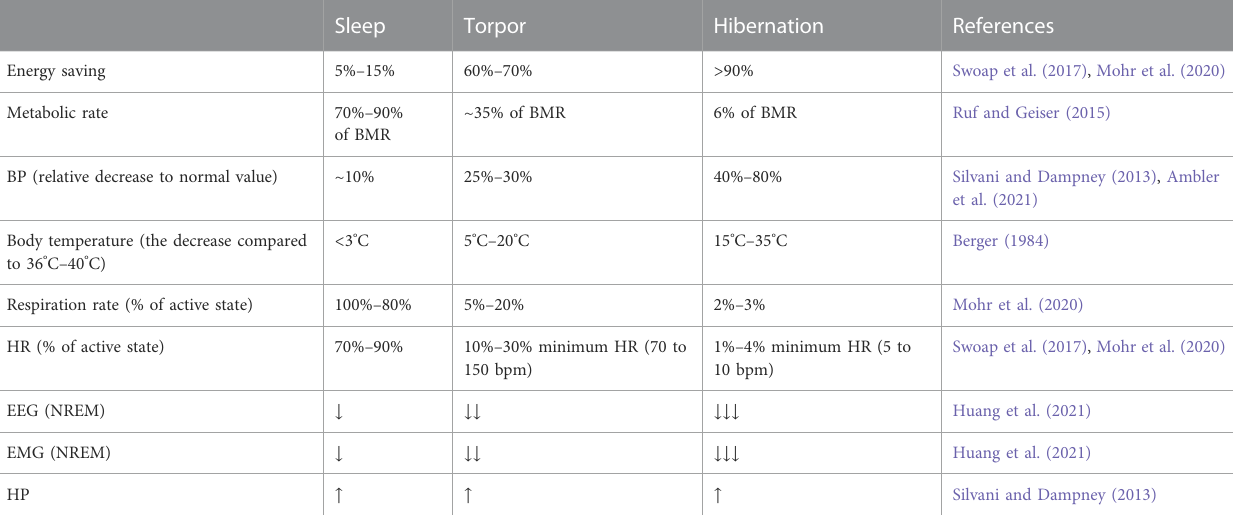
TABLE 1 Physiological characteristics of sleep, daily torpor, and